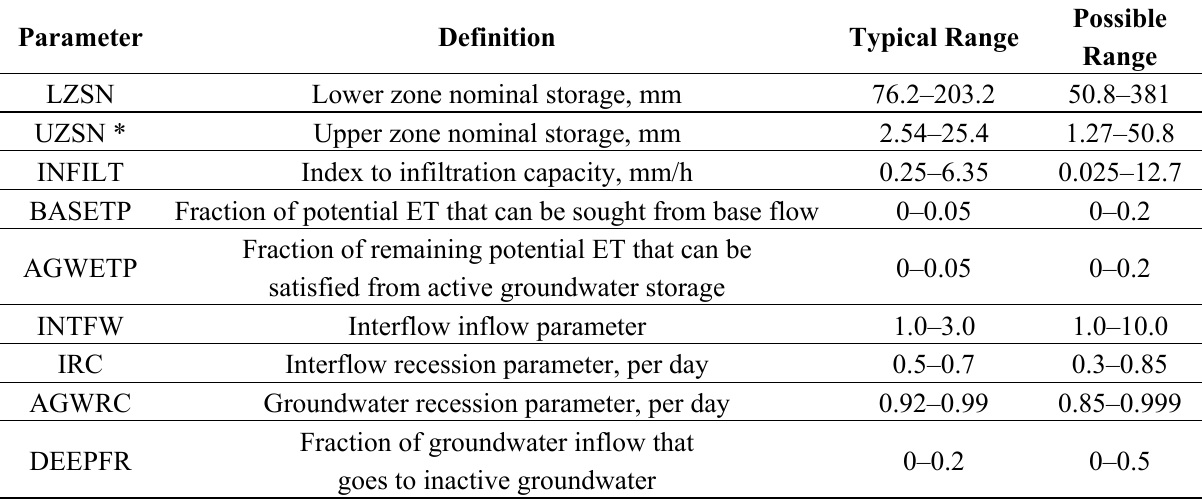
Table 3. Calibration parameters for hydrologic simulation of HSPF and their ranges